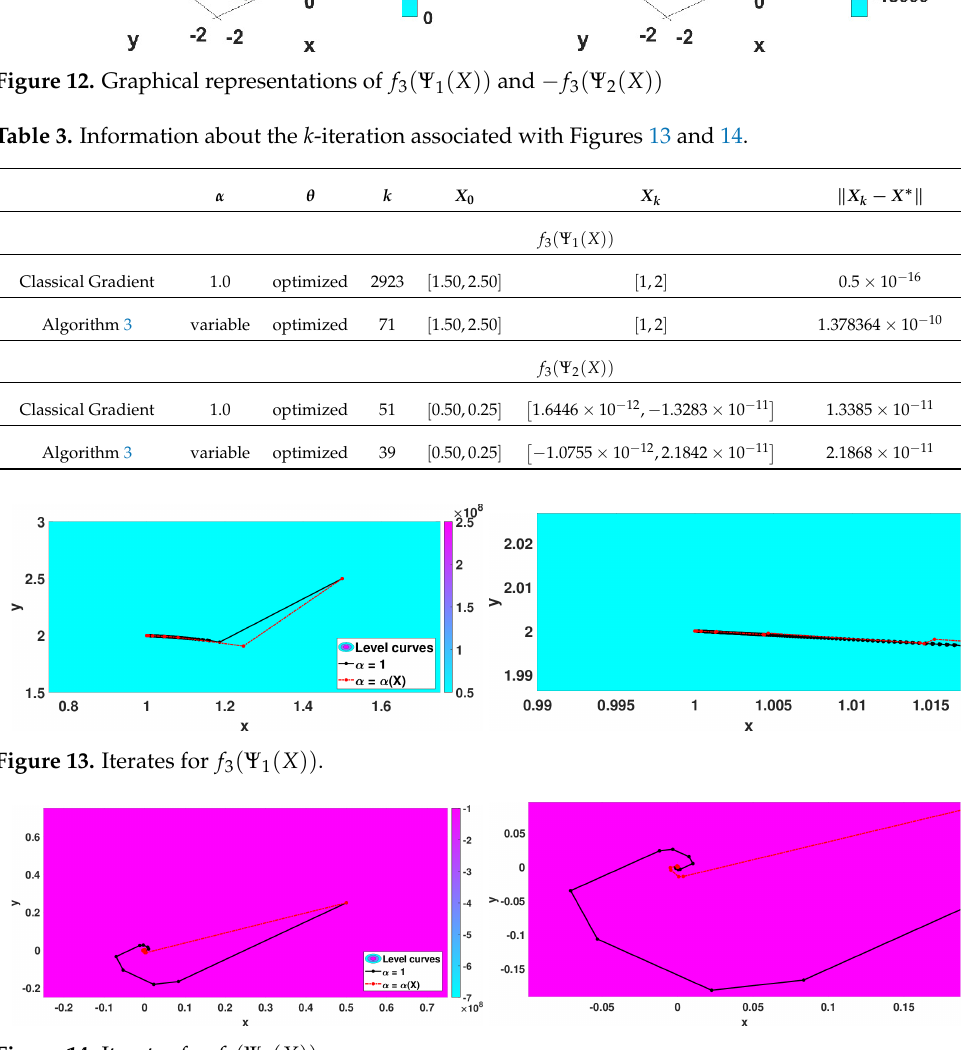
Figure 14. Iterates for f 3 ( Ψ 2 ( X ))